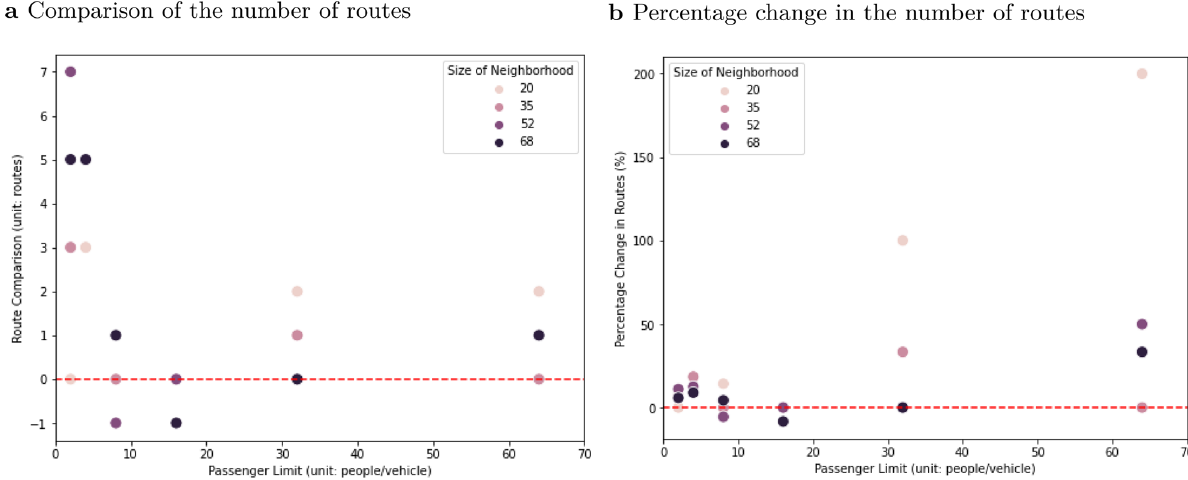
Figure 8. Performance comparison between DNN-based and non-DNN solutions in terms of the number of routes. Negative numbers on the y-axis means that the DNN-based solution required fewer routes than the non- DNN solution. The x-axis is vehicle capacity and the y-axis is the difference in the number of routes ( a ) and the percentage change in the number of routes ( b ) is calculated as Eq.